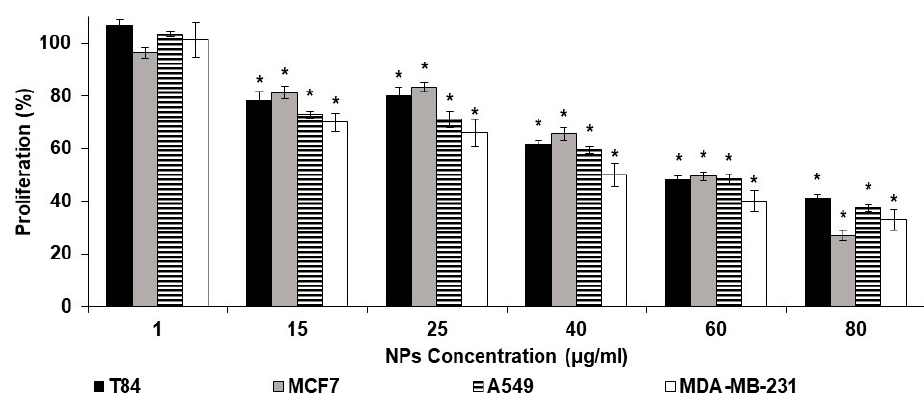
Figure 7. Cell proliferation assay of A549, MCF7, MDA-MB-231, and T84 tumor cell lines treated with PLGA@Ag2S_R1, including maslinic acid. The percentages of proliferation of the cell lines obtained are shown. Data represent the mean values ± SD of triplicate cultures. Statistically significant differences with respect to untreated control ( p < 0.05) are represented with one asterisk (*).